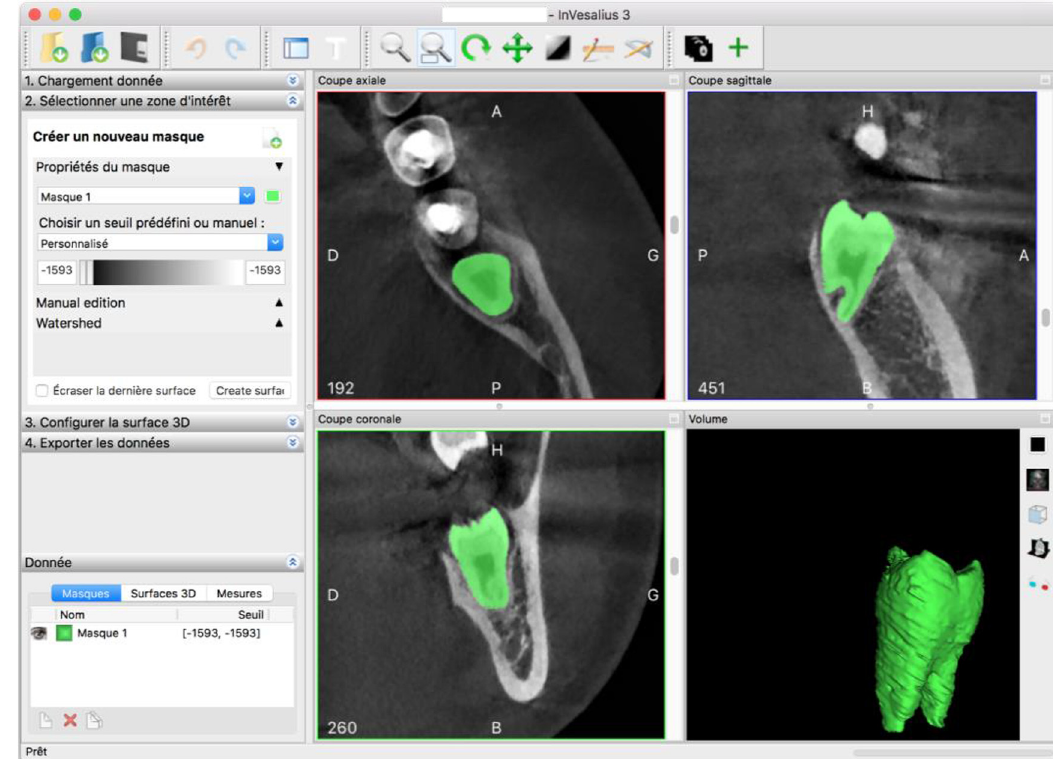
Fig. 2. Selection of the region of interest using the InVesalius ® software.